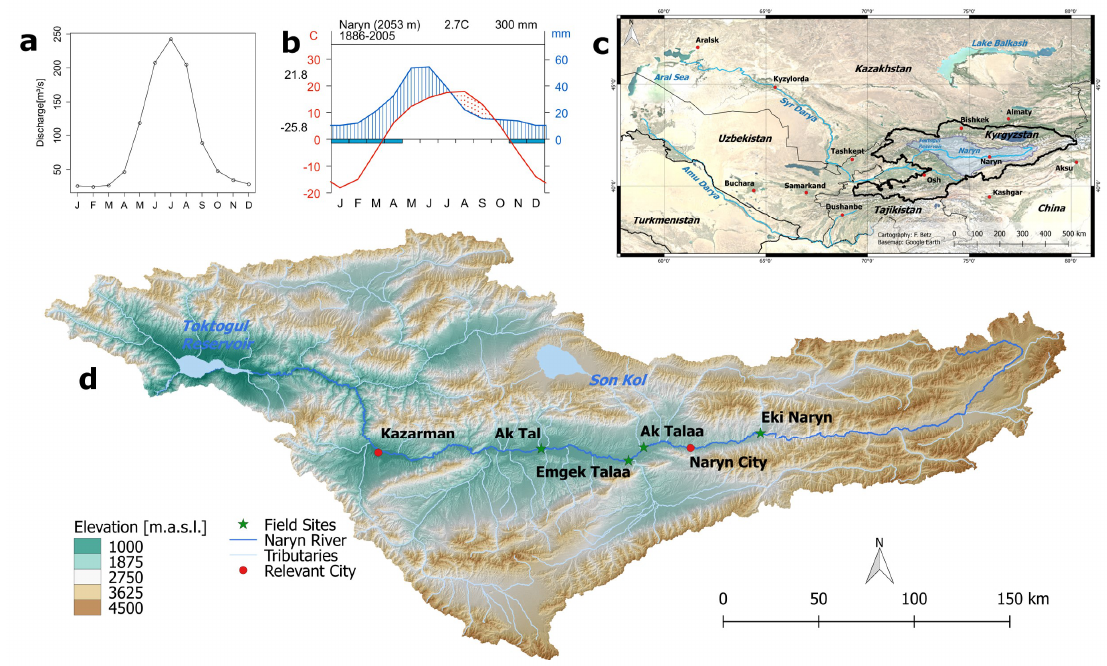
Figure 1. Overview over the study area: ( a ) hydrograph and ( b ) climate diagram of Naryn City; ( c ) location of the Naryn catchment within Central Asia and ( d ) detailed map of the catchment